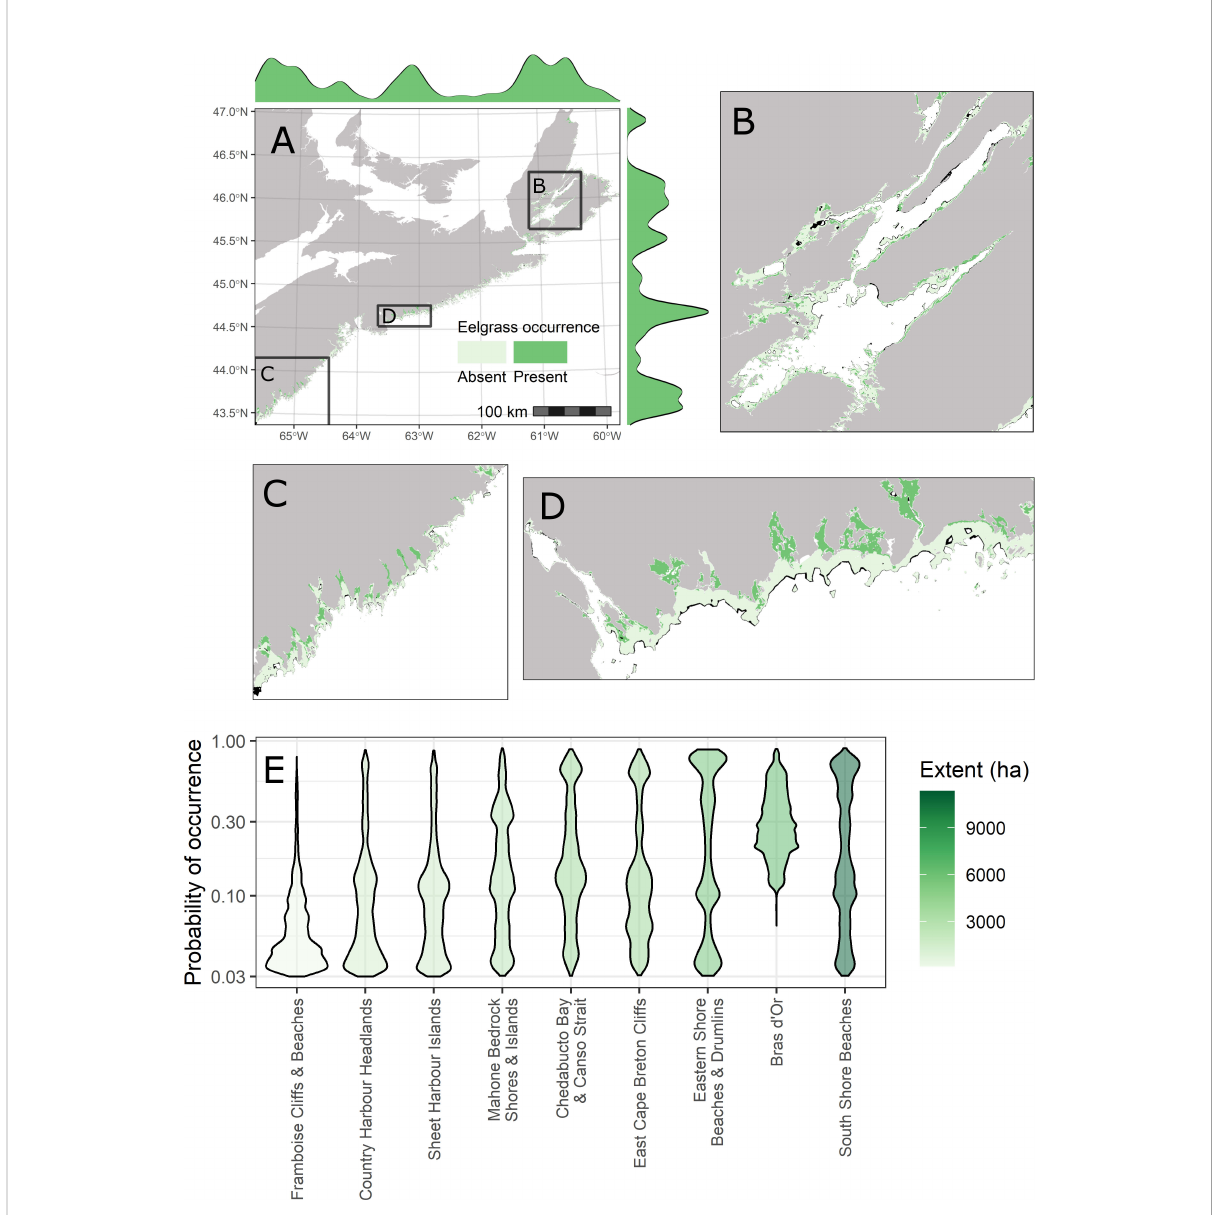
FIGURE 4 Coastal-scale extent of suitable eelgrass habitat and spatial variation among coastline classes. (A) Binary predictions of the ensemble eelgrass model. Pixel shade indicates the result of reclassifying mean ensemble predicted probability of occurrence based on the average threshold across cross-validation runs that maximized the value of the true skill statistic (TSS). Light green = absent, Dark green = present. Marginal density plots are the kernel density estimates for eelgrass presence predictions across longitudinal (x-axis) and latitudinal gradients (y-axis). Black polygons denote the extents of zoomed in insets shown for the Bras d ’ Or Lakes (B) , South Shore Beaches (C) and Eastern Shore Beaches and Drumlins (D) . Areas of model extrapolation are masked out on maps (black pixels). (E) Violin plots with kernel density estimates for probability of occurrence predicted by the ensemble model among physiographic and oceanographic coastline classes (see Figure 1). Deeper shades of green indicate a greater extent (ha) of suitable eelgrass habitat within a coastline